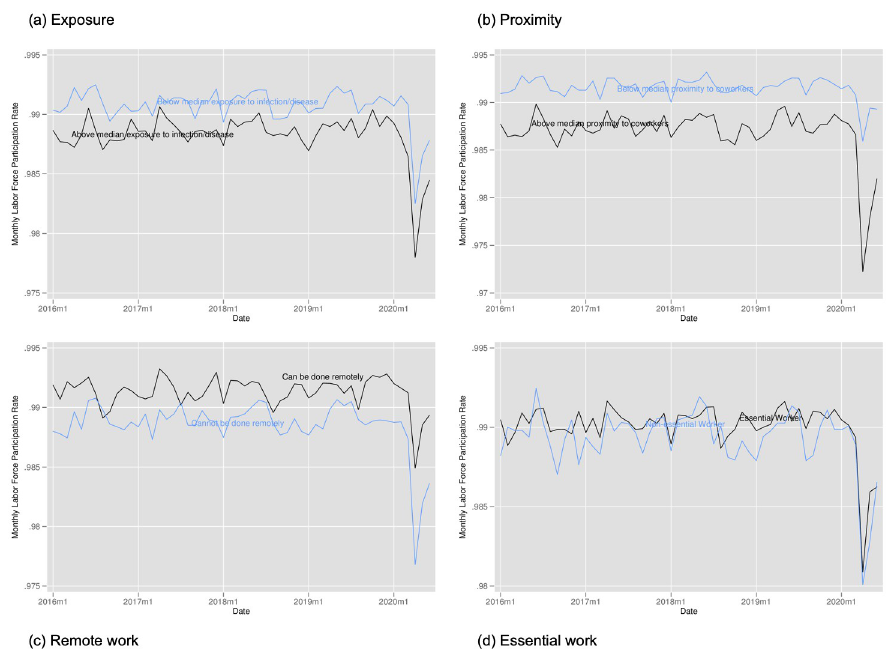
Fig 8. Labor force participation by exposure to disease, proximity to coworkers, remote work, and essential work. Notes: Authors’ calculations. Data from the Current Population Survey. The time period is January 2016 to June 2020. Each panel plots the monthly labor force participation rate. Panel A for individuals in occupations above and below the median for our index of exposure to the disease. Panel B for individuals in occupations above and below the median for our index of proximity to coworkers. Panel C for individuals in occupations designated by [1] as being able to be done remotely. Panel D for individuals in occupations designated as essential and non-essential by the Labor Market Information Institute. Individuals in the labor force were at work; held a job but were temporarily absent from work due to factors like vacation or illness; were seeking work; or were temporarily laid off from a job during the reference